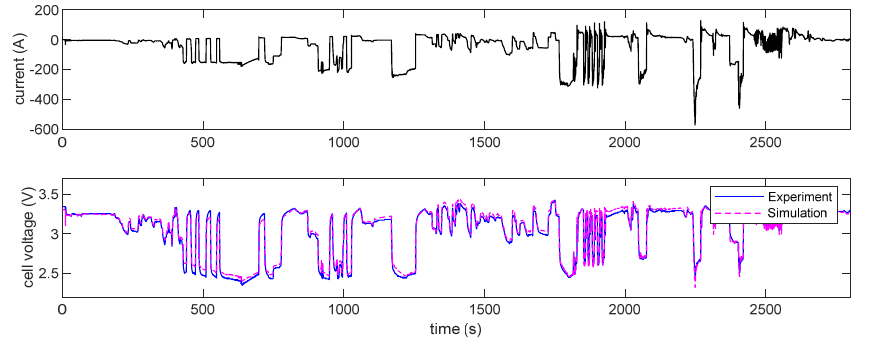
Figure 11. Real-world driving data validation.